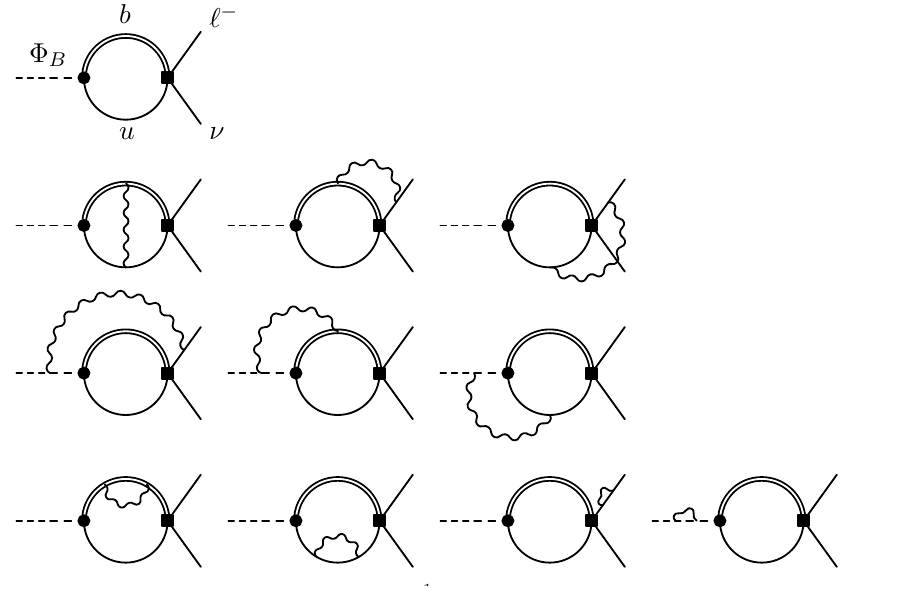
) in (3.5) (ie. the non-radiative part, hence no ( γ ) , p 2 B Φ B